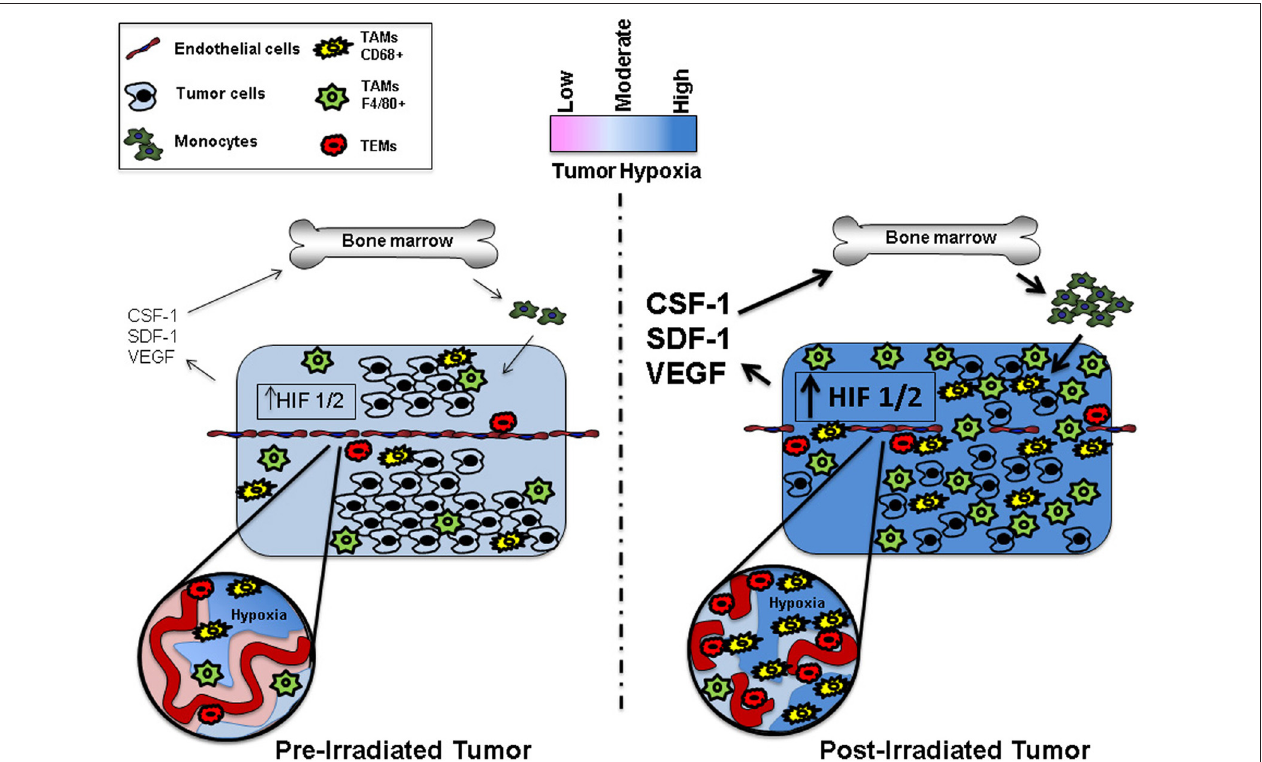
FIGURE 1 | Representation ofthe microenvironment of pre- and postirradiated tumors. The post-irradiated tumor has increased levels of hypoxia, upregulated HIF 1/2 signaling, and expression of a diverse spectrum